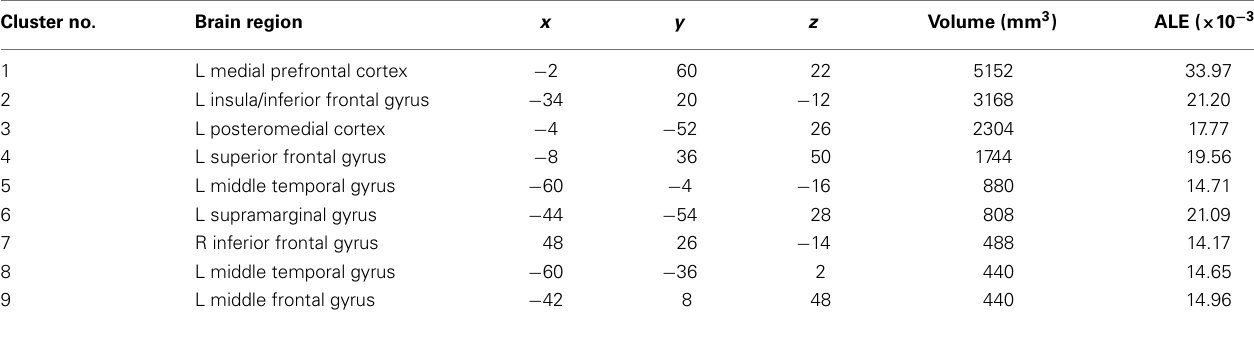
Table 2 | Meta-analysis of activation foci for self-traits compared with baseline (159 foci; 21 experiments). Cluster